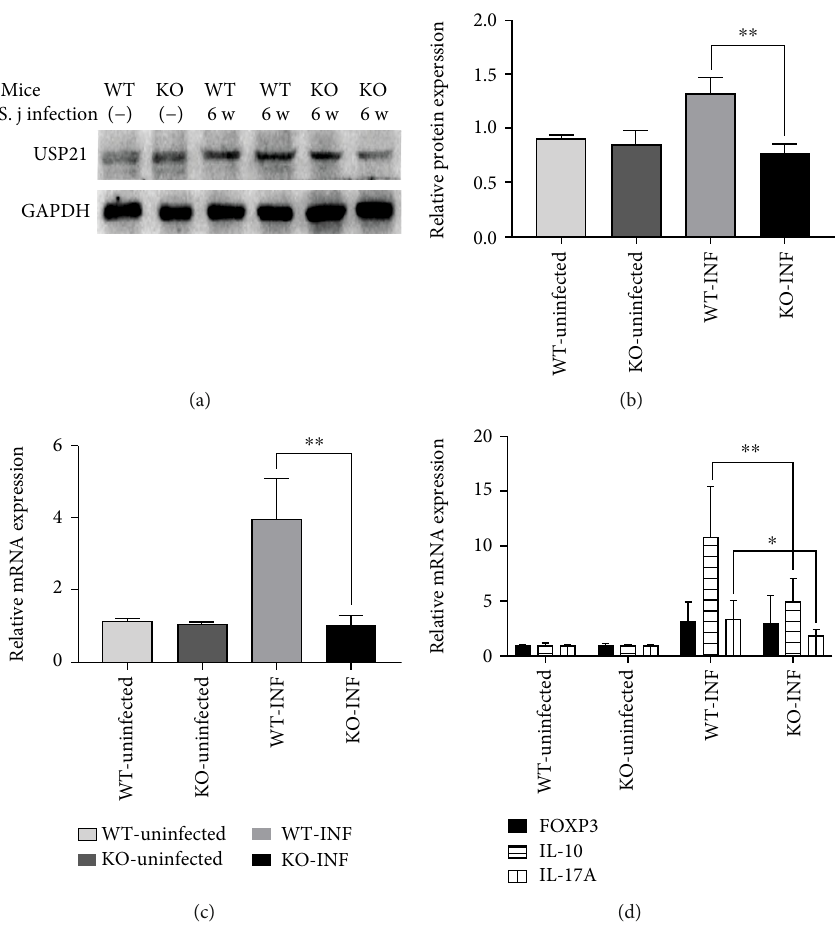
Figure 4: Liver immunity in USP21 fl / fl FOXP3 cre mice infected with S. japonicum . (a) Representative images of USP21 protein expression in the in WT and KO mice in the NC and INF groups determined using Western blotting ( n = 6 mice/group). (b) Comparison of protein expression in the WT and KO mice in the NC and INF groups ( n = 6 mice/group). The data are presented as the means ± SD , and the di ff erence between the infection groups was signi fi cant ( ∗∗ p < 0 : 001 ). (c) Comparison of the USP21 mRNA levels between WT and KO mice in the NC and INF groups ( n = 6 mice/group). The data are presented as the means ± SD , ∗∗ p = 0 : 001 for the comparison between the infection groups. (d) Comparison of the levels of the FOXP3, IL-10, and IL-17 mRNAs in the WT and KO mice from the NC and INF groups ( n = 6 mice/group). The data are presented as the means ± SD ; for the comparison between the infection groups: IL-10 ∗∗ p = 0 : 003 and IL-17 ∗ p = 0 : 026